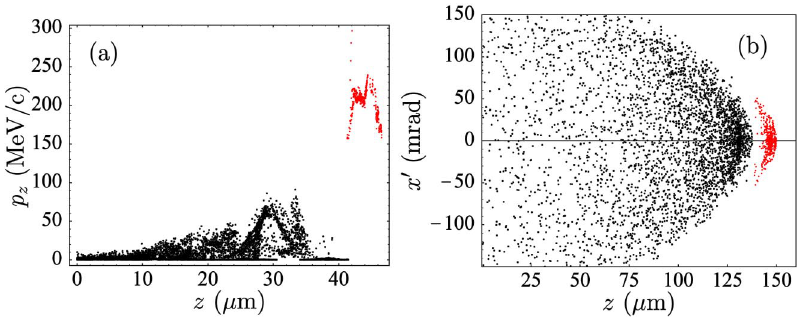
FIG. 15. (Color) z (cid:6) p phase-space projection of a 3D electron distribution (a) after a laser propagation distance of (cid:4) 1 : 36 mm inside z a preformed plasma channel and (b) z versus beam divergence x 0 after a propagation of 4 : 8 mm in vacuum. The laser-plasma (cid:1) 0 : 8 (cid:4) m , duration (cid:12) (cid:1) L=c (cid:1) 58 fs , spot size at waist r parameters were a laser strength a (cid:1) 2 : 15 , carrier frequency (cid:1) 0 (cid:1) 1 : 8 (cid:5) 10 19 cm (cid:6) 3 , and channel radius r (cid:1) 40 (cid:4) m . nominal plasma density n c 0